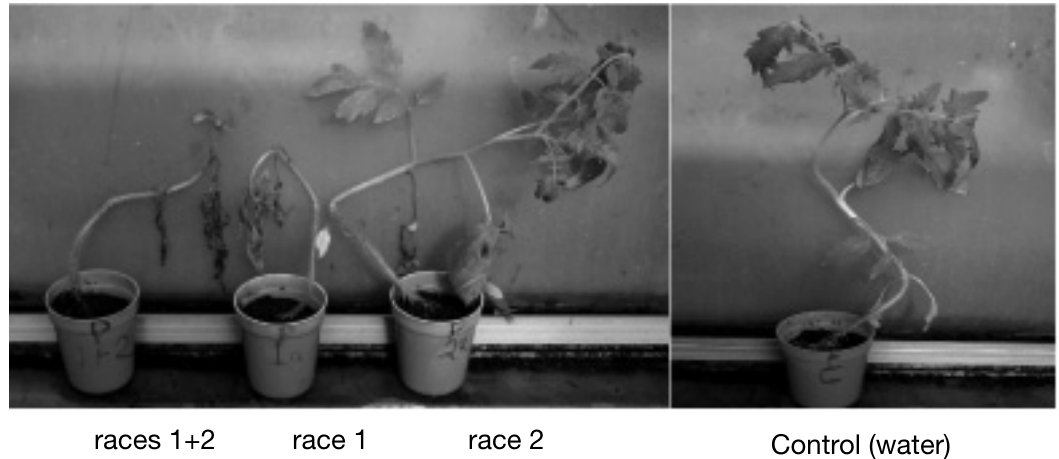
Fig. 2. Symptoms on the tomato cv. Ponderosa inoculated (as described in Figure 1) with various races of Fusarium oxysporum f. sp. lycopersici 24 days after